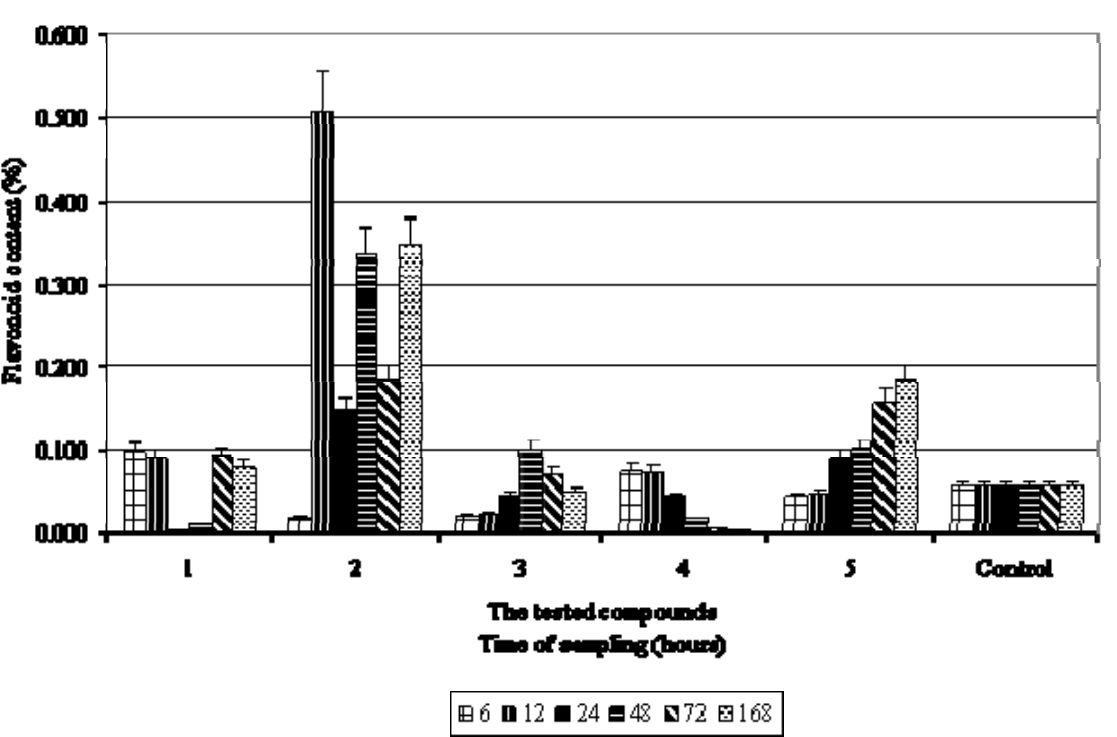
Figure 3. Abiotic elicitation activity evaluations of prepared compounds 1 - 5 and Control (without